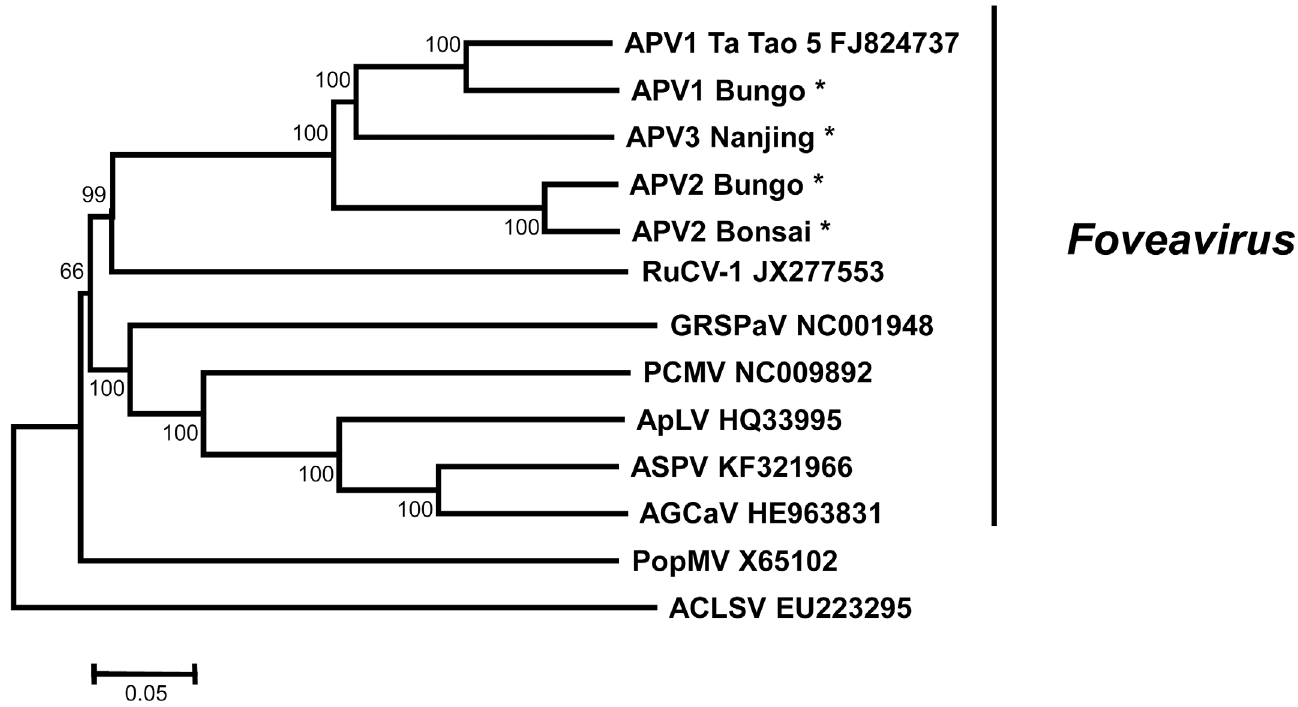
Fig 2. Unrooted phylogenetic tree reconstructed with the complete genome sequence of representative members of the family Betaflexiviridae . Tree was constructed by the neighbor-joining method and the statistical significance of branches was evaluated by bootstrap analysis (1,000 replicates). Only bootstrap values above 65% are indicated. The scale bar represents 5% nucleotide divergence. The abbreviations followed by the accession numbers are: APV1, 2 or 3, Asian prunus virus 1, 2 or 3, respectively; RuCV-1, Rubus canadensis virus 1 ; GRSPaV, Grapevine rupestris stem pitting associated virus ;